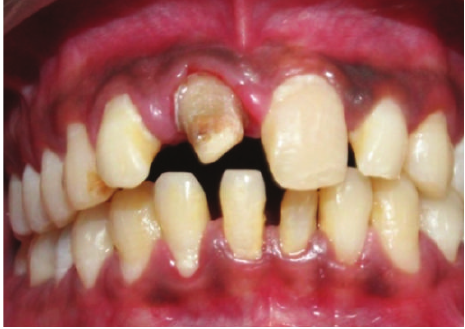
Figure 42: Histopathology report: radicular cyst.